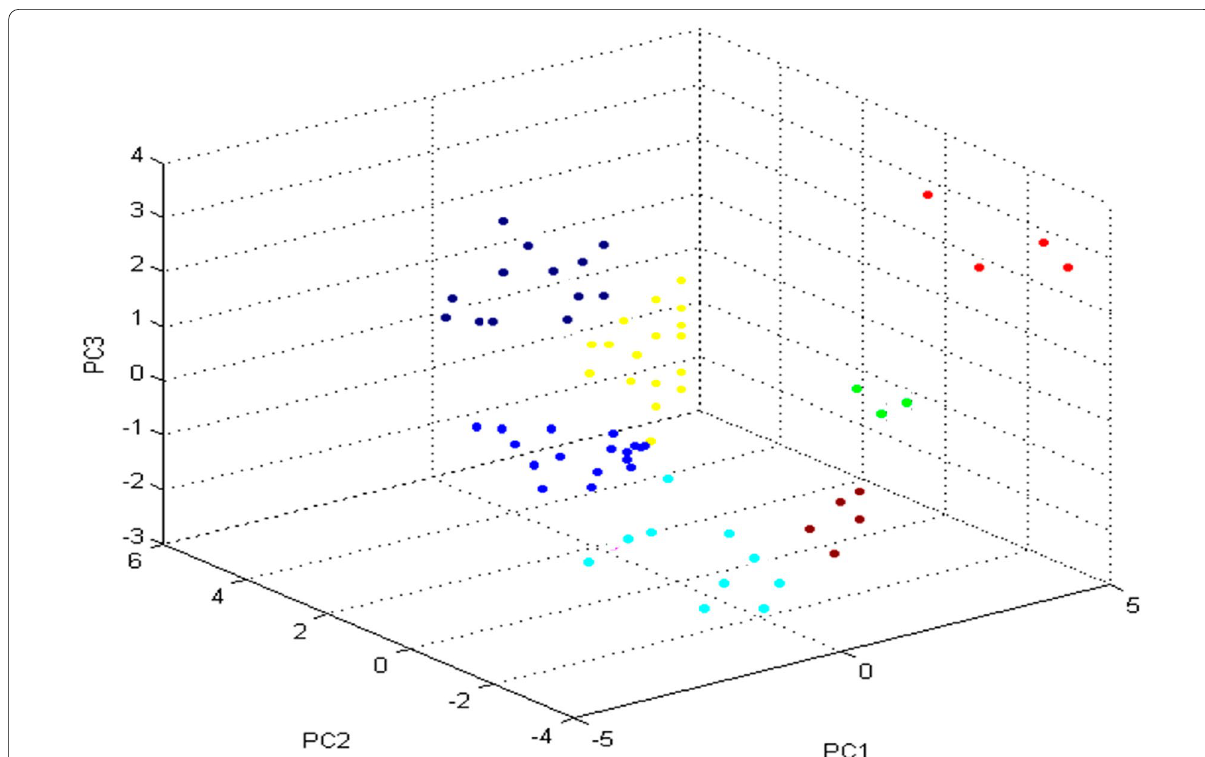
Fig. 4 PCA dimensional image showing the grouping of 69 Pseudomonas spp.; a the alliance of P. lundensis (blue), P. fragi (yellow), P. oryzihabitans (blue black), P. stutzeri (aqua), P . fluorescens (maroon), P. putida (red), and P. aeruginosa (green) in the 1st three principalcomponent